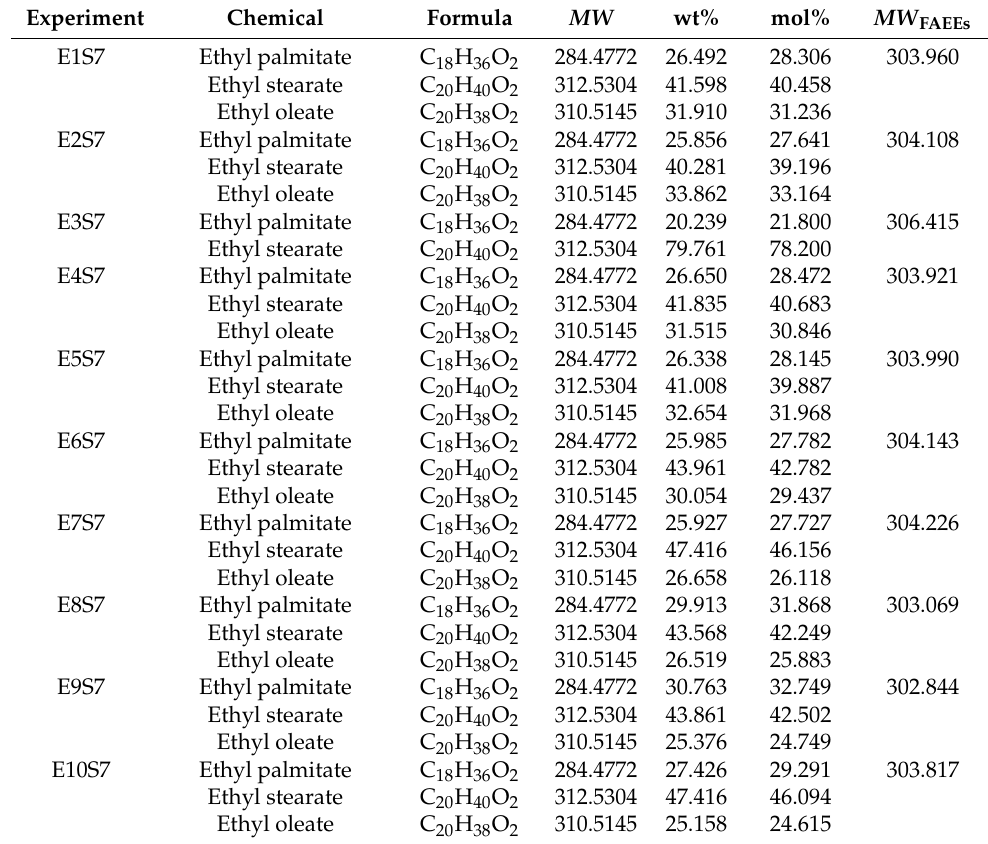
Table 3. FAEE composition from beef tallow